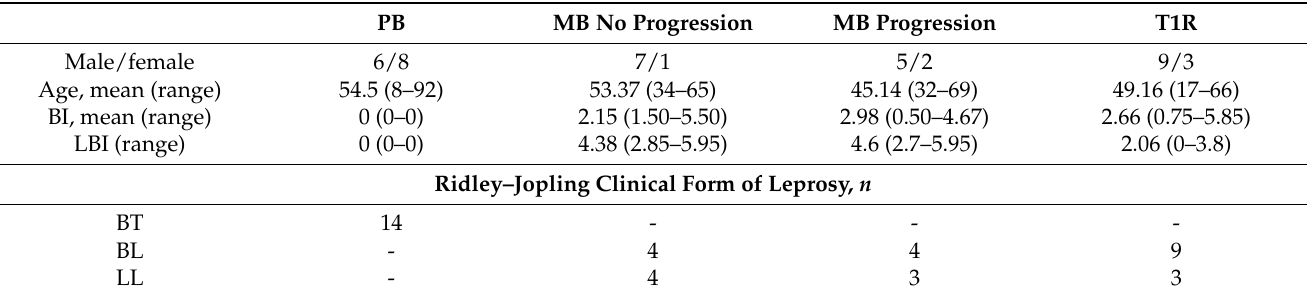
Table 1. Baseline characteristics of leprosy patients included in the study. PB MB No